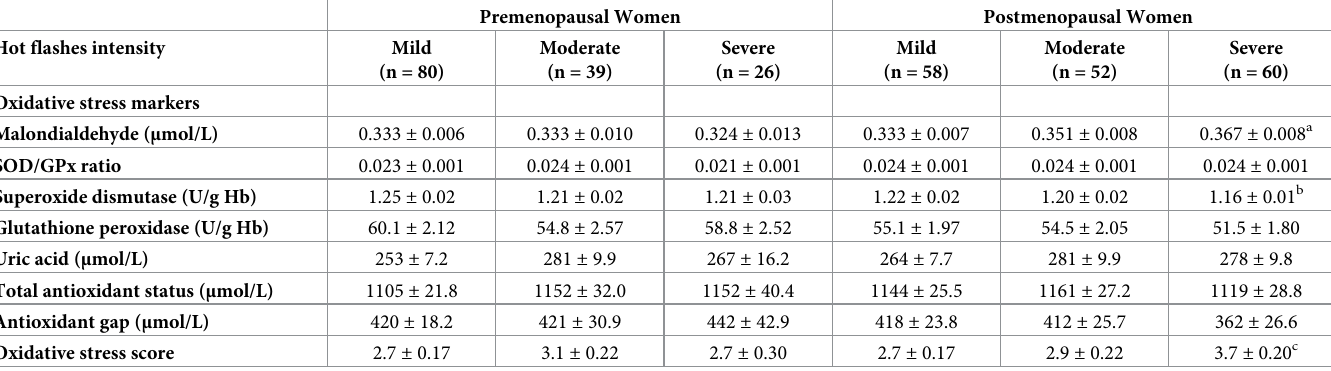
Table 2. Oxidative stress markers by hot flashes intensity in study groups.